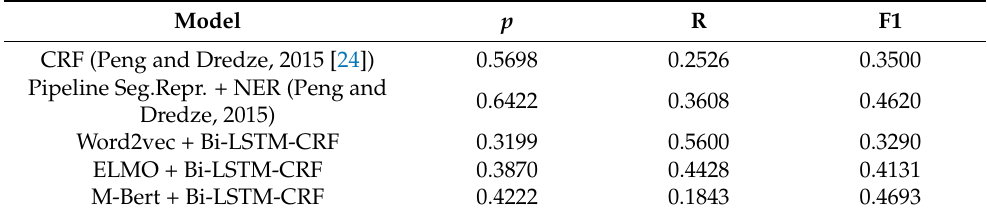
Table 3. Accuracy of different benchmark models in People-Daily Chinese dataset. Model p R CRF (Peng and Dredze, 2015 [24])